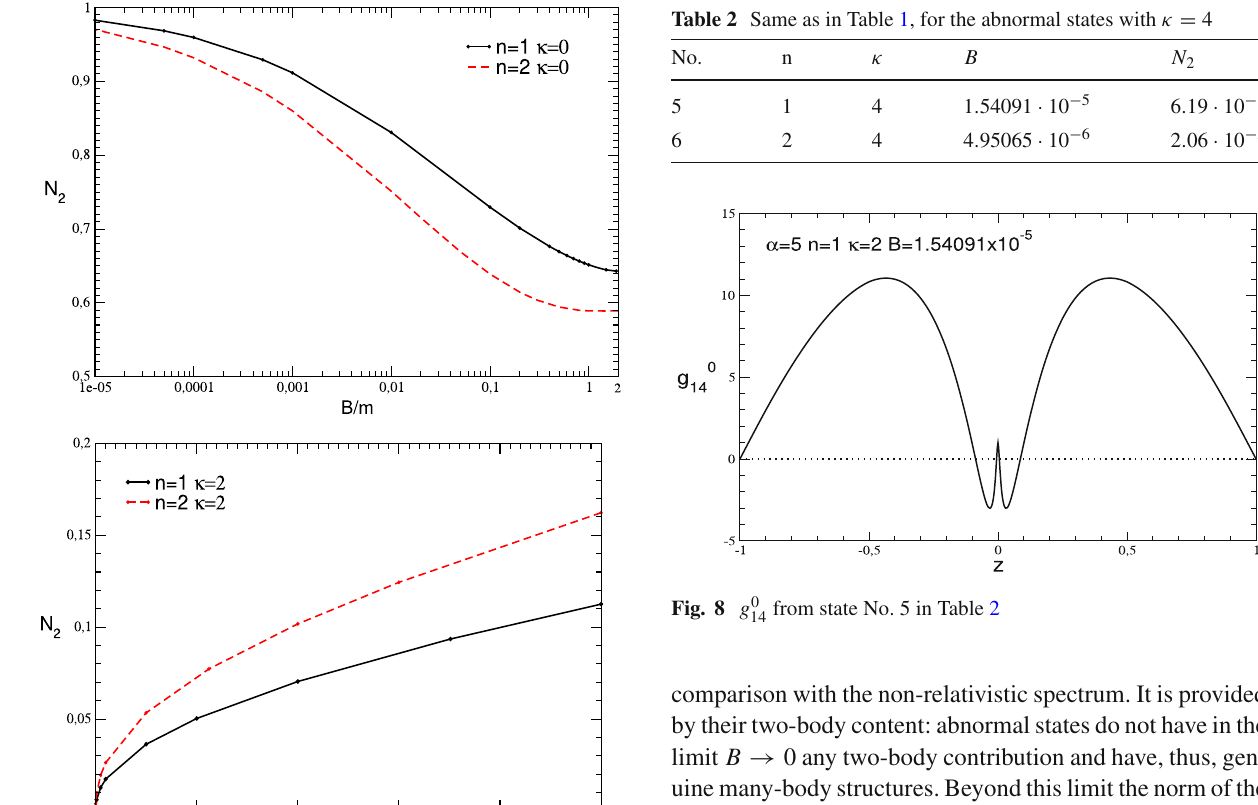
and N 2 ( 2 m ) ≈ 0 . 59 for n=2. For the ground state n=1, these